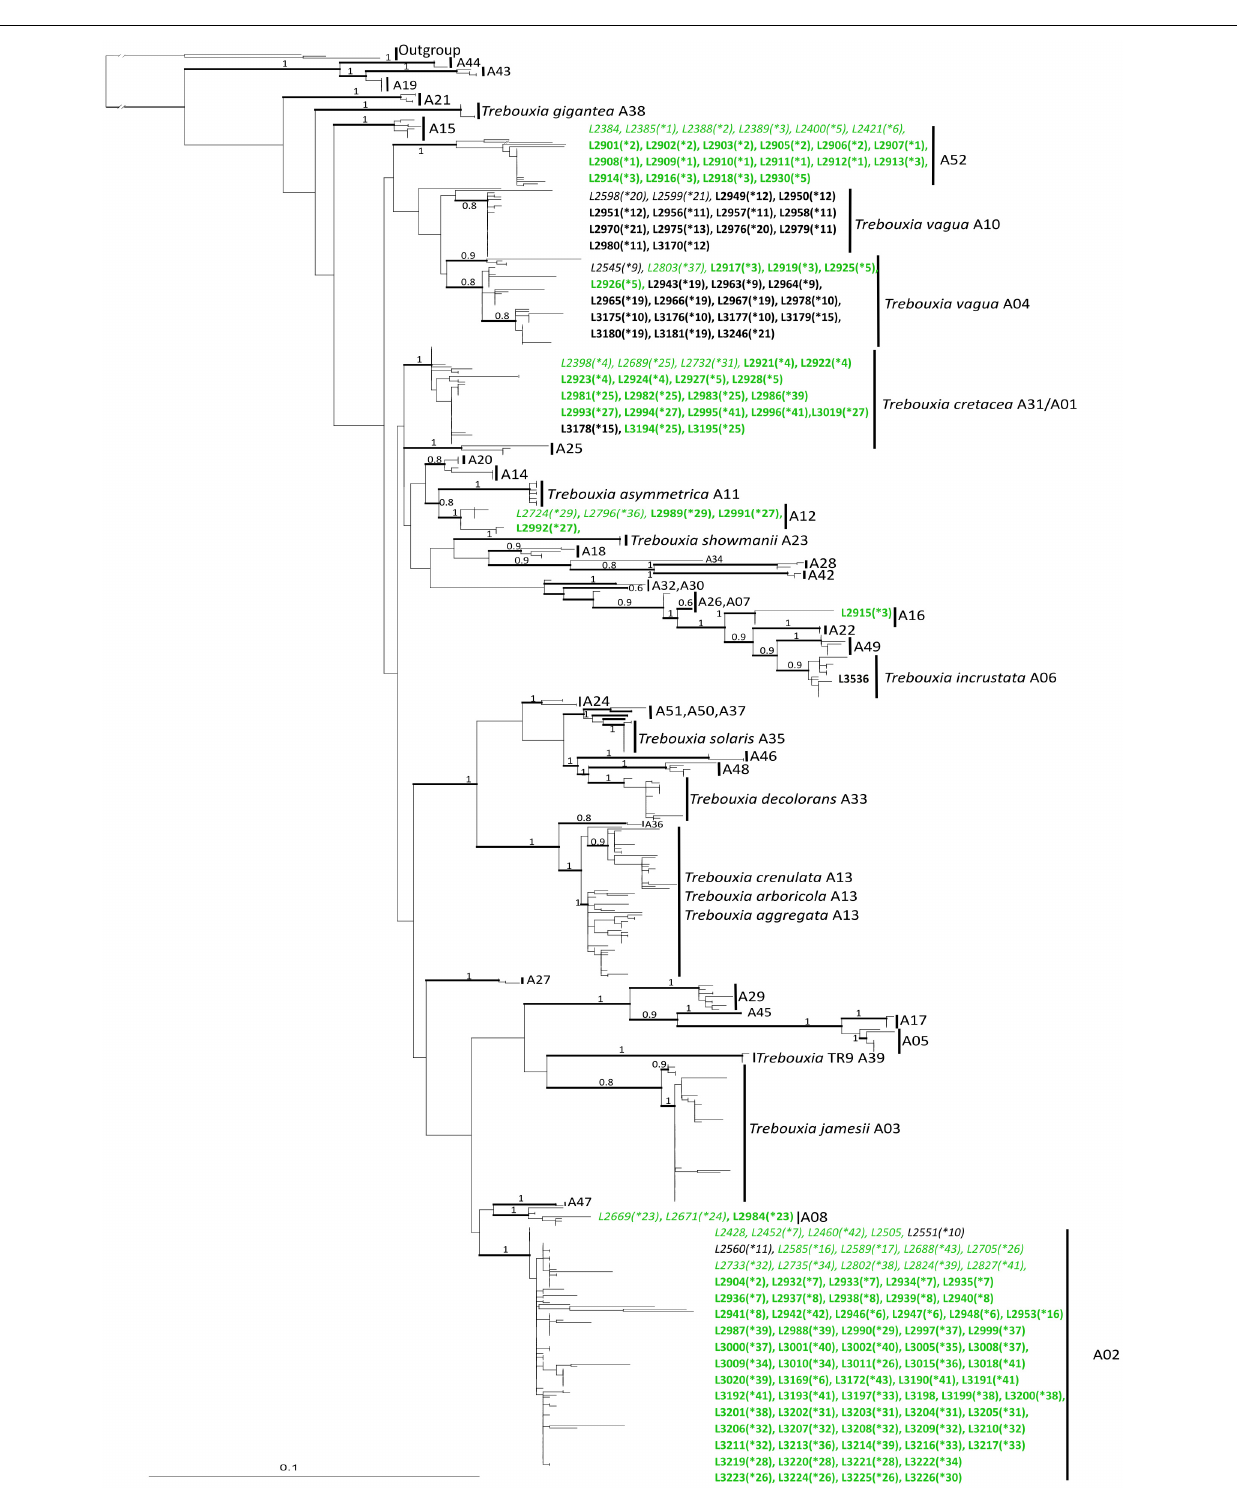
Frontiers in Microbiology |